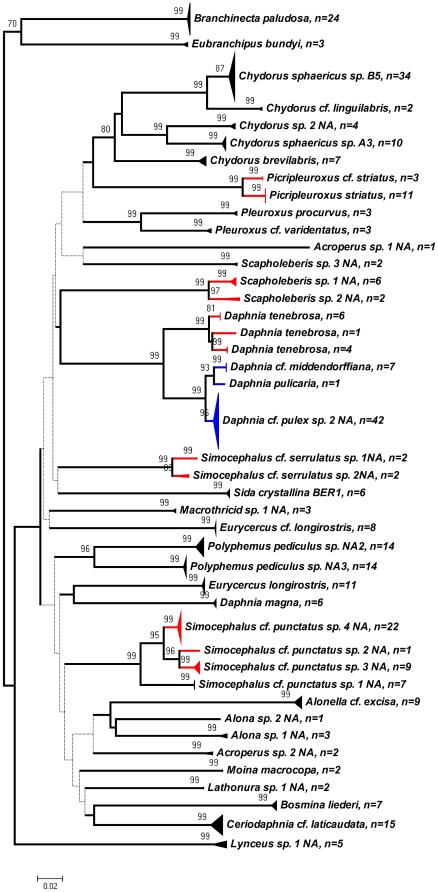
Neighbour-joining tree of COI sequences for all species of Branchiopoda obtained from Churchill, Manitoba.Species names and sample size are given for each branch. Red branches indicate genetic clusters (representing species or provisional species) separated from one another by a divergence of <5%, indicating that further study may be required to establish species status. Daphnia tenebrosa displays distinct intraspecific clusters, which differ from one another by an average of 2.5–3.1%, and are also coloured red. Blue colouring is used to highlight three species in the Daphnia pulex complex that each appear to form monophyletic mitochondrial lineages as indicated by bootstraps, but which show <2% COI divergence. The numbers above each branch indicate the level of bootstrap support (1000 replicates), and bootstrap values of less than 70% are indicated by the dotted lines.